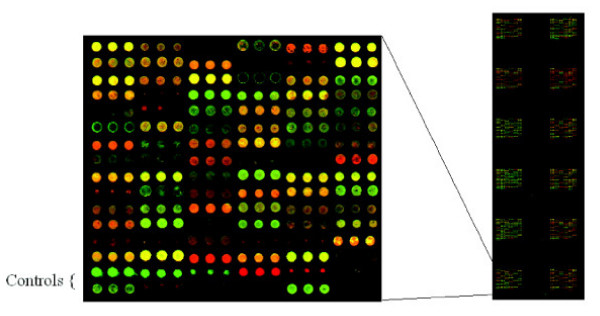
Scanned fluorescence image of an antibody microarray detected by two-color RCA. 96 baits including 84 antibodies were spotted onto microscope slides coated with nitrocellulose. 12 identical arrays were printed on each of seven slides. Each antibody was printed in triplicate on each array in order to form an 18 by 16 array of dots. A test sample labeled with biotin and a pooled reference sample labeled with digoxigenin were co-incubated on the microarray, and bound proteins from both samples were detected by RCA. The microarray was scanned for Cy3 fluorescence (from the test sample) and Cy5 fluorescence (from the reference sample).